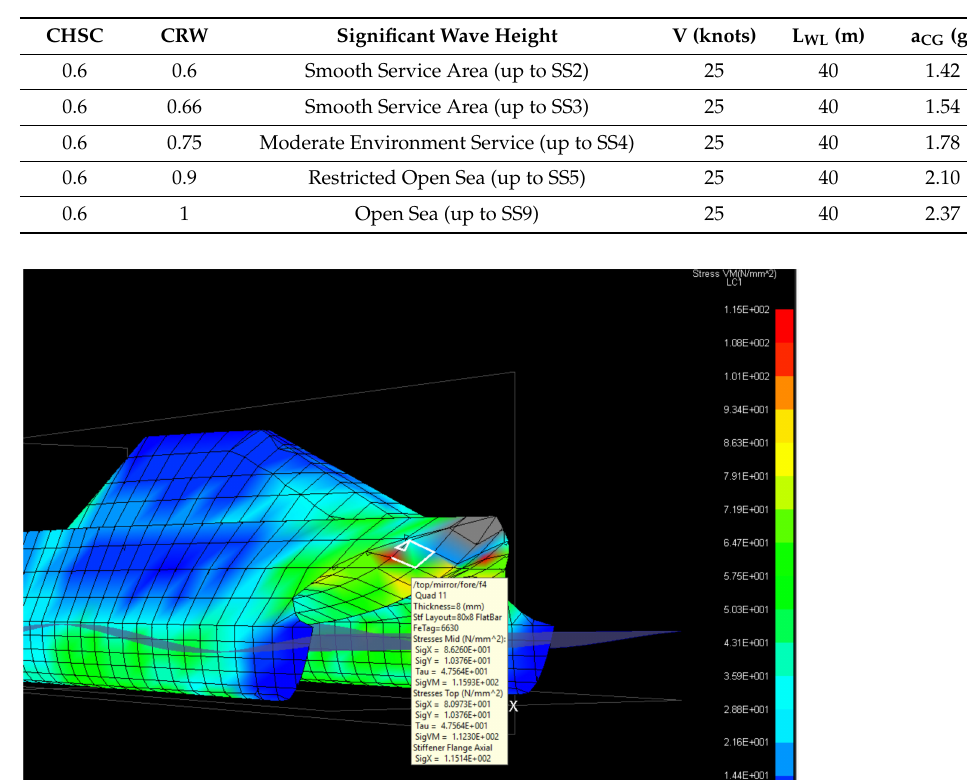
Table 10. Calculated a CG values based on sea states.